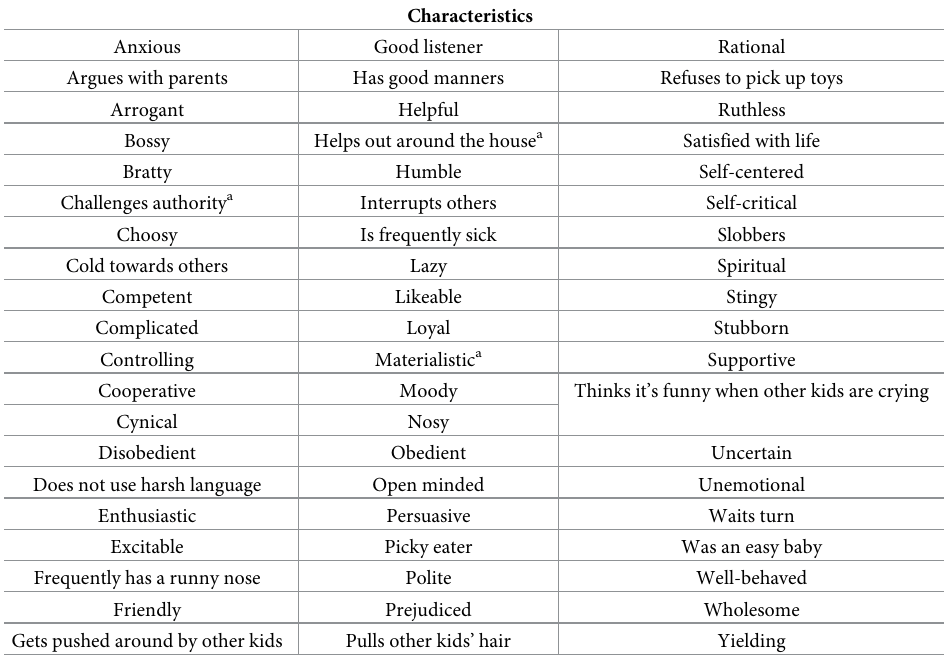
Table 2. Characteristics showing no effect of gender in ratings of